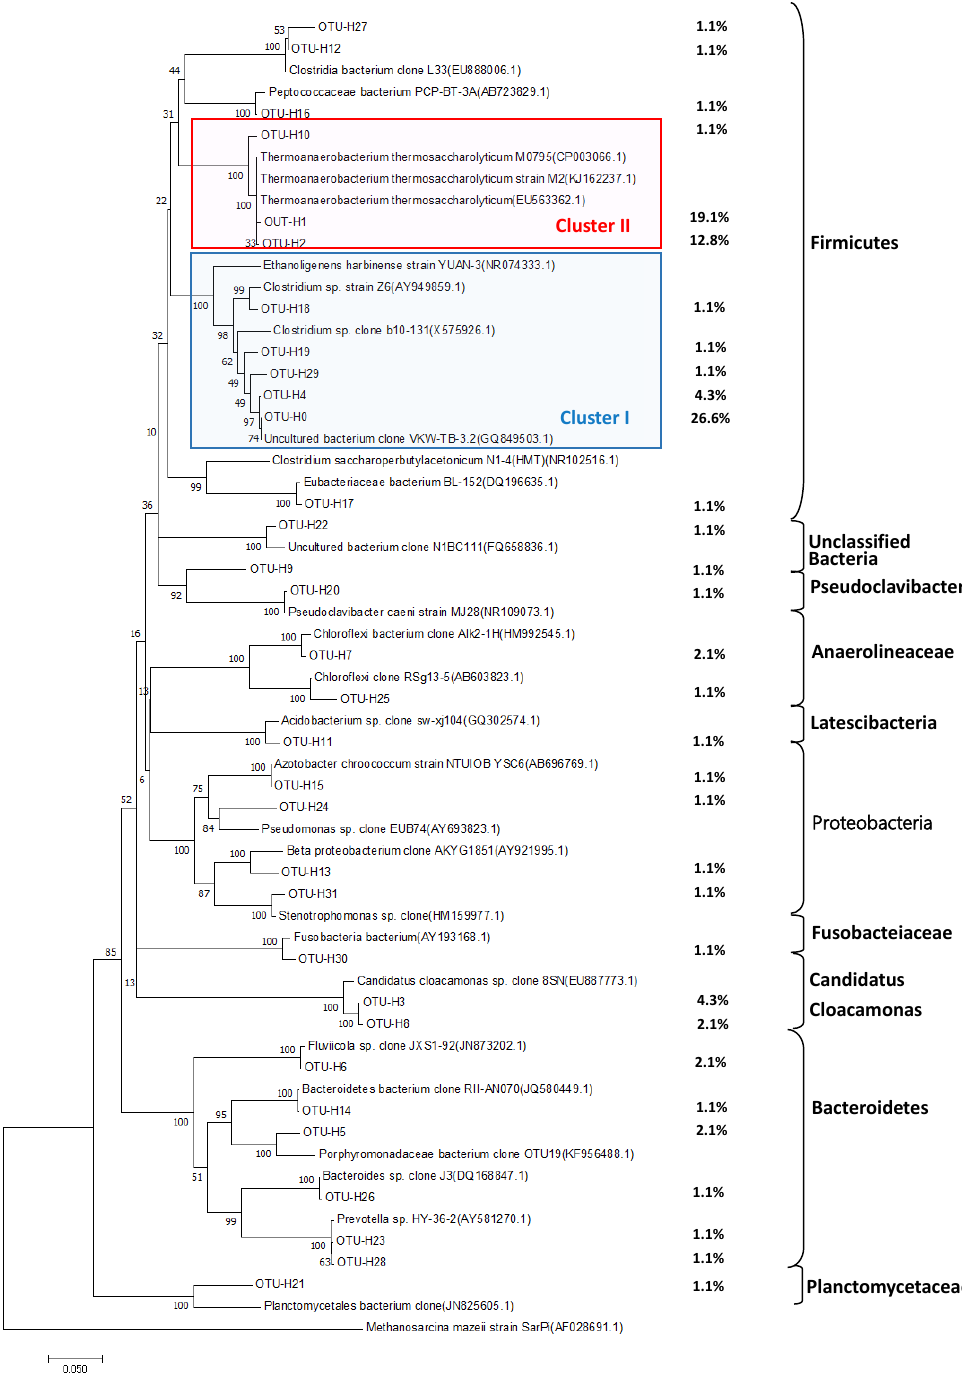
Figure 5. Phylogenetic tree of the bacterial operational taxonomic units (OTUs) in the thermophilic hydrogen production reactor and their close relatives retrieved in GenBank database based on 16S rRNA gene sequences. The relative abundance of each OTU are shown on the right. Numbers at nodes represent bootstrap values. The scale bar represents 0.05 substitution per nucleotide position. The confidence thresholds of the taxonomic classification for most OTUs illustrated on the right were above 98%, whereas the confidence threshold for OTU-H11 a ffi liated with phylum Latescibacteria was